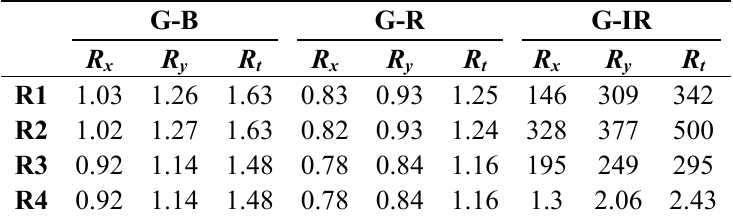
Figure 16. The CIR composite of the four-band images; ( a – c ) respectively the multispectral images obtained by using the methods using the first-order polynomial, second-order polynomial and homography model and using the RANSAC directly; ( d ) the multispectral images obtained by using our method. Table 3. The errors for registering near infrared, red and green band to the blue band. G-B